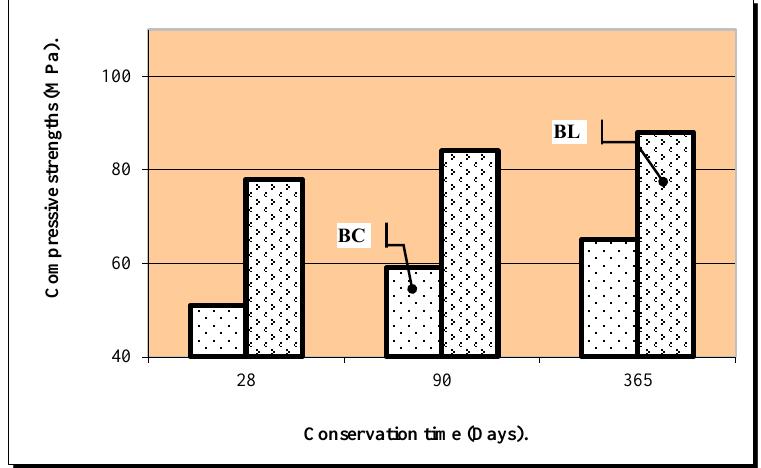
Fig. 4. Evolution of compressive strength as a function of curing